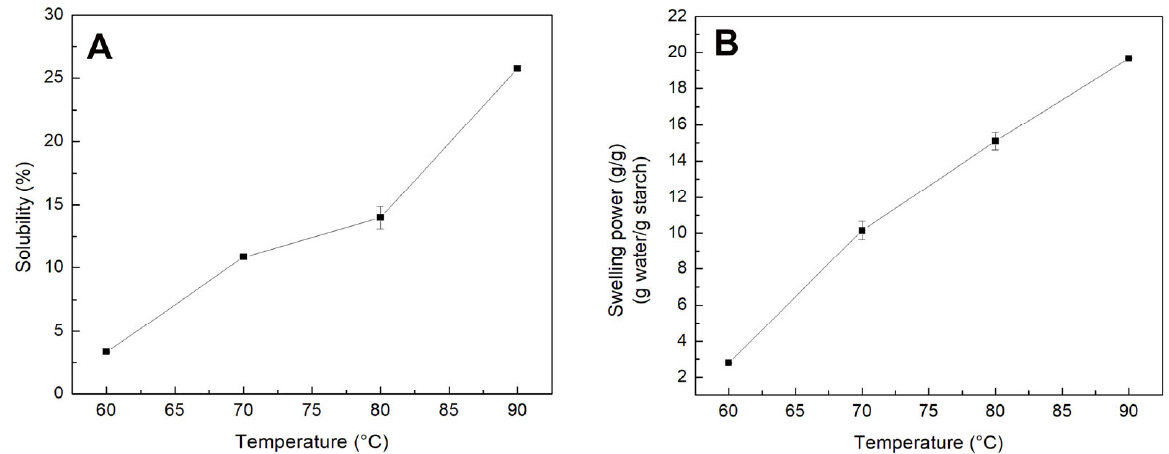
Figure 3. ( A ) Solubility. ( B ) Swelling power of isolated colok starch at different temperatures.